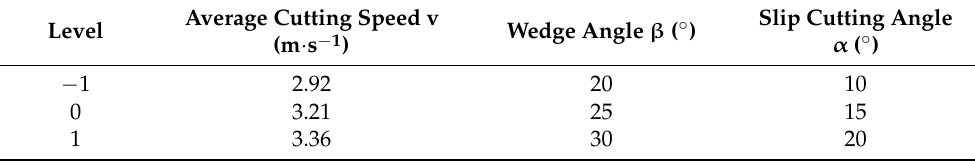
Table 2. Factors and Levels of the Unsupported Cutting Multi-Factor Test.